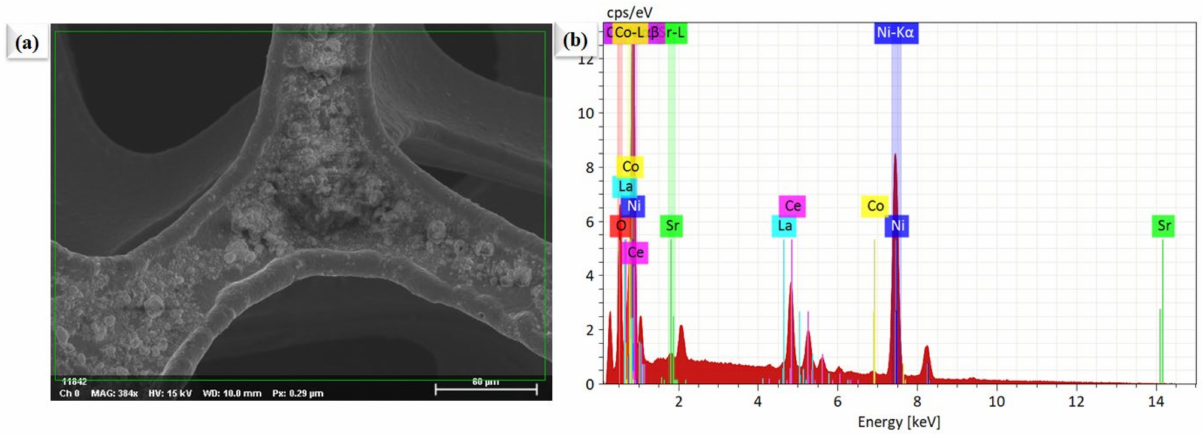
Figure 4. The surface morphology and compositional investigations. ( a ) SEM image of La 0.2 Sr 0.8 Co 0.8 Ce 0.2 O 3 − δ particles planted on porous Ni-foam, ( b ) EDS image of La 0.2 Sr 0.8 Co 0.8 Ce 0.2 O 3 − δ embedded on porous Ni-foam as shown in Figure